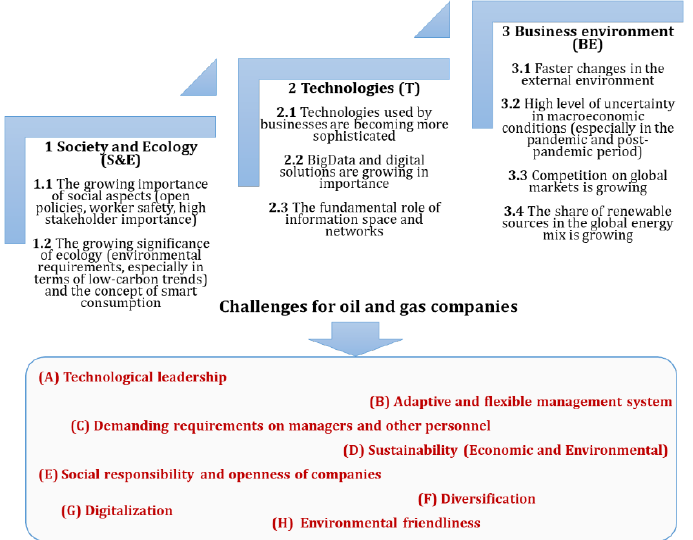
Figure 3. Global trends and challenges for the strategic development of oil and gas companies. Source: Created by the authors, data from [14,21,40,64–72]. Source: Created by the authors, data from